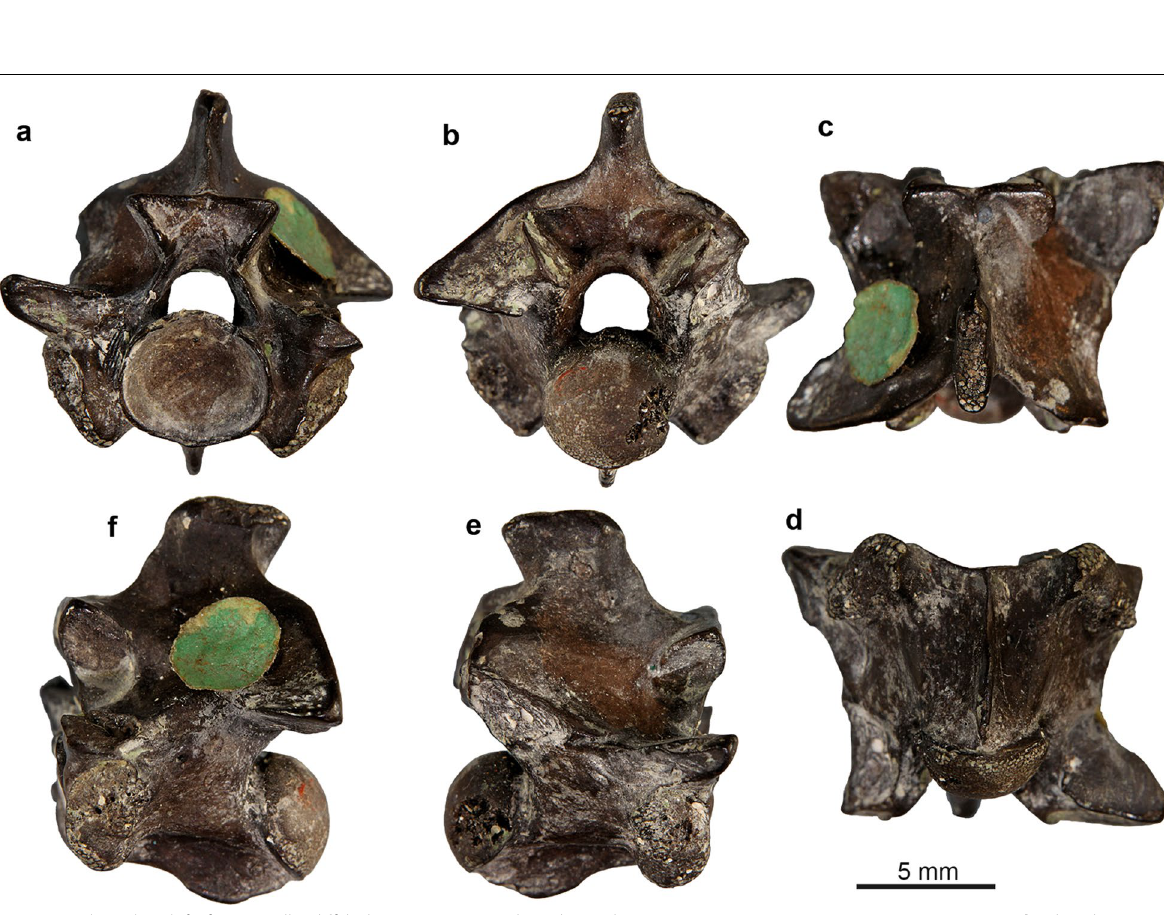
Fig. 34 Paleryx rhombifer from Hordle Cliff: holotype anterior mid-trunk vertebra (NHMUK PV OR 25259) in anterior ( a ), posterior ( b ), dorsal ( c ), ventral ( d ), right lateral ( e ), and left lateral ( f )